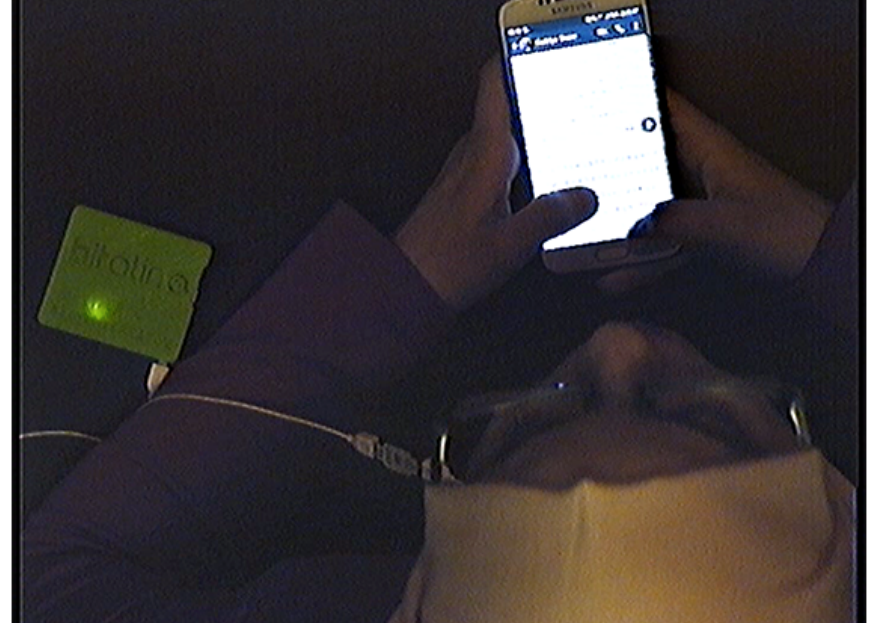
Figure 1. Screenshot from the video recording of one of our pilot